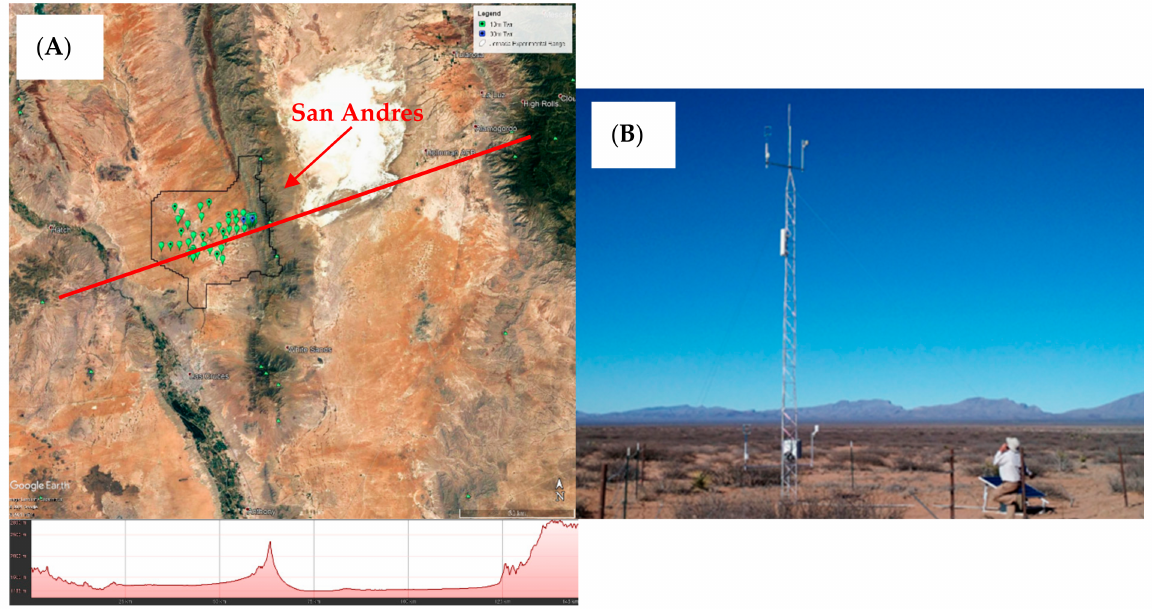
Figure 3. ( A ) Study domain centered northeast of Las Cruces, NM showing the JER boundary in black and the elevation profile of a transect through the inner domain. ( B ) 10 m Meteorological Sensor Array (MSA) tower with San Andres in background.